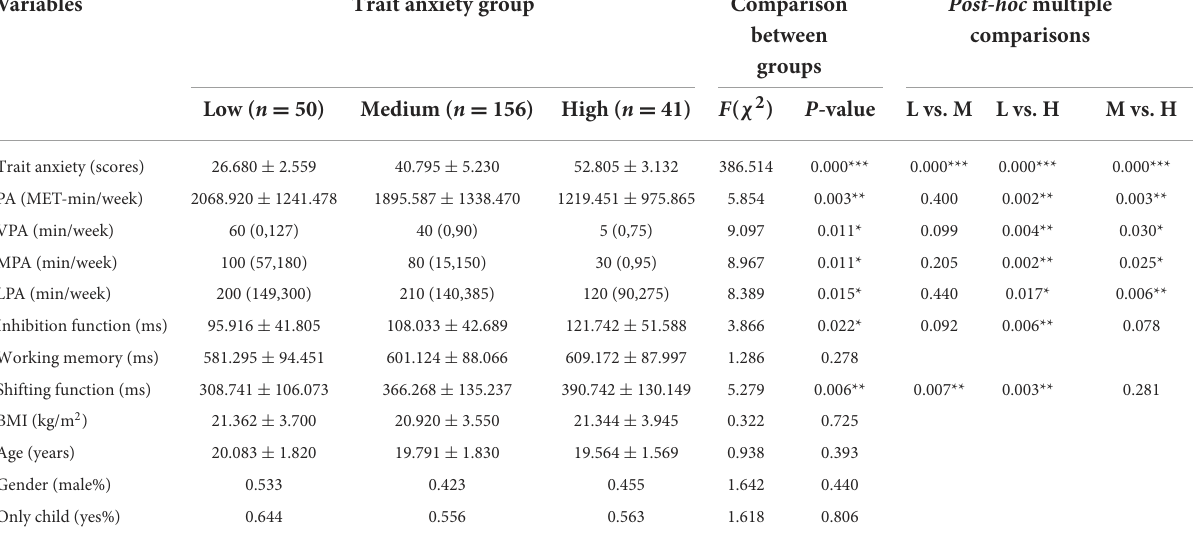
Post-hoc multiple between comparisons groups